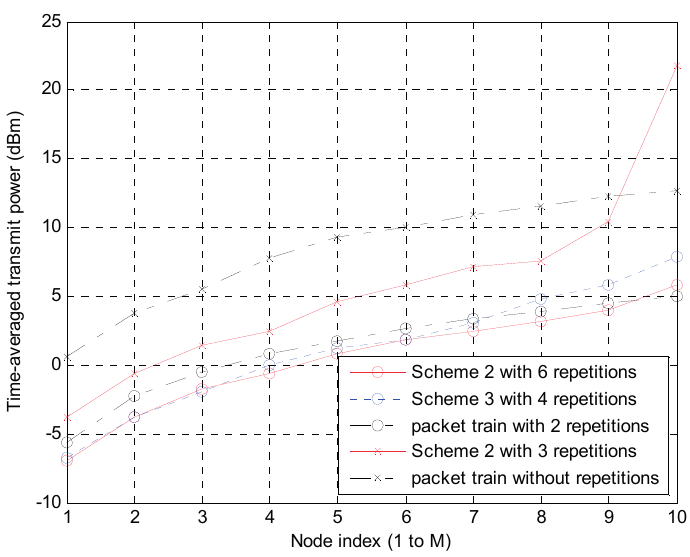
Figure 14. Time-averaged transmit power of each node.